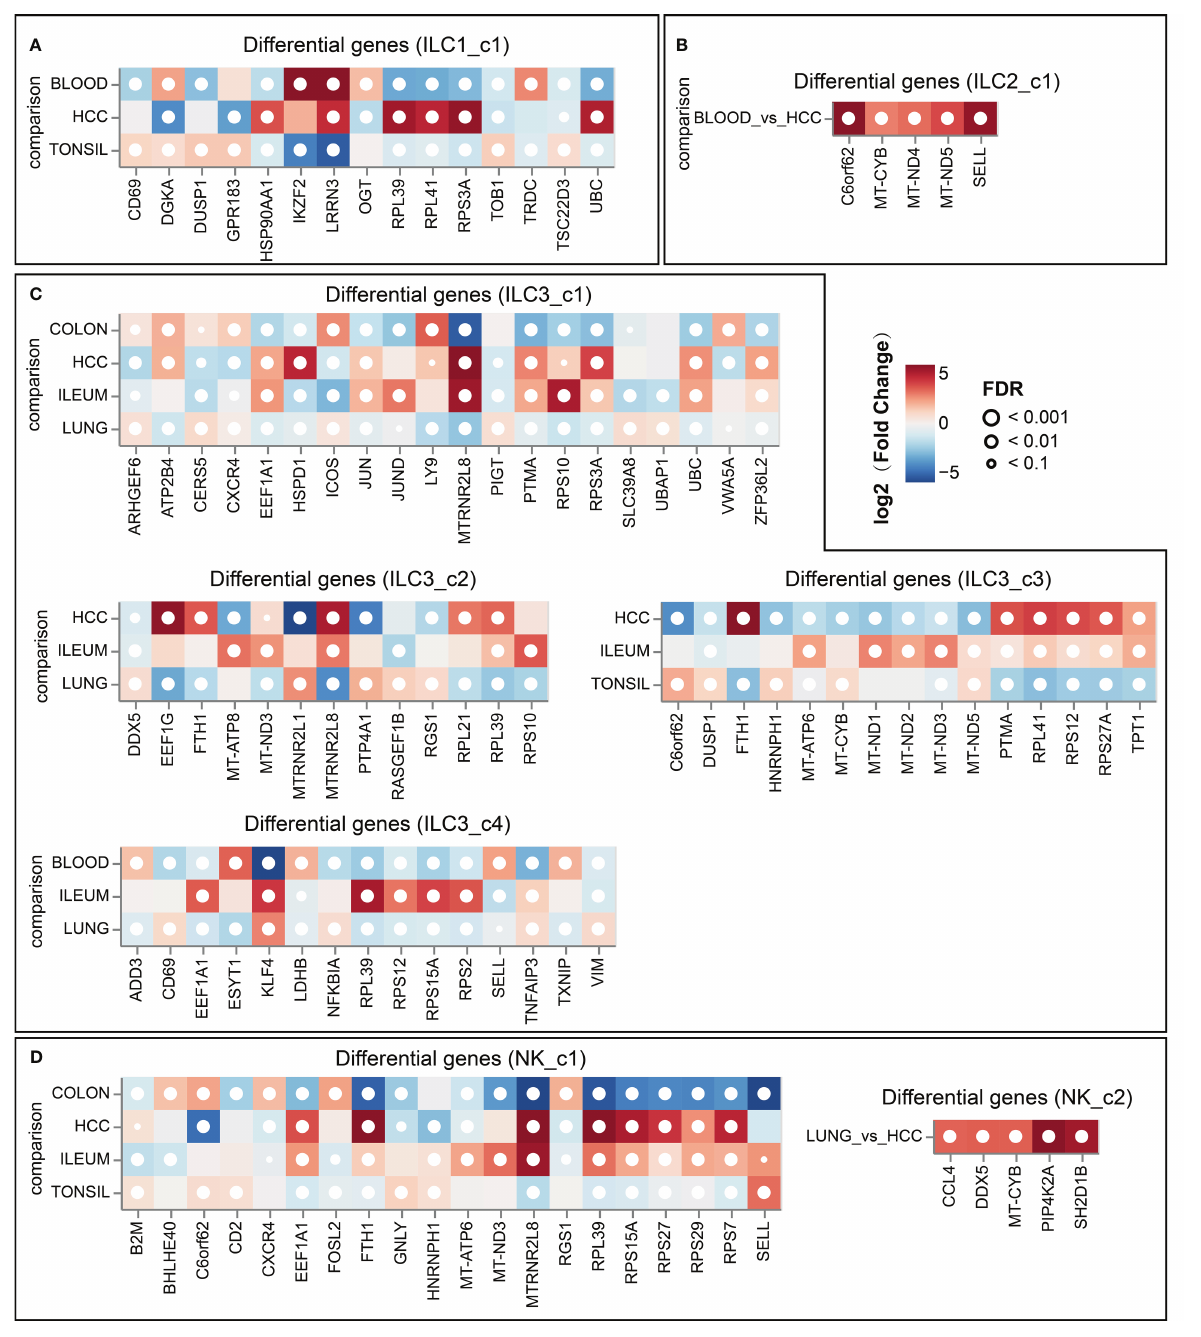
FIGURE 7 Top 5 differentially expressed genes in ILC subsets ( A , for ILC1_c1 subset; B , for ILC2_c1 subset; C , for ILC3 subsets; D , for NK subsets) across different tissues (DESeq2 on